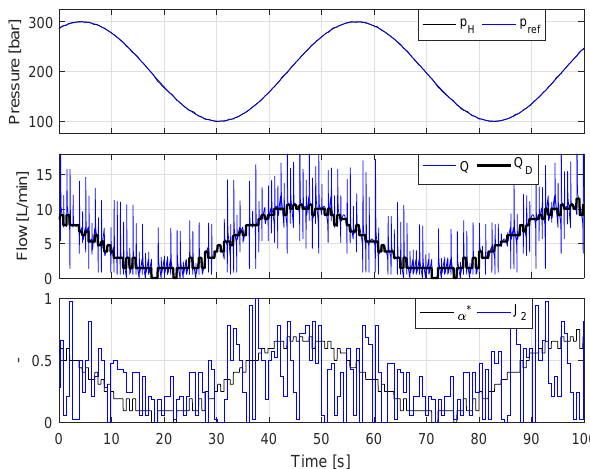
Figure 10: Pressure tracking response using the DEA MPC algorithm without the energy cost function.